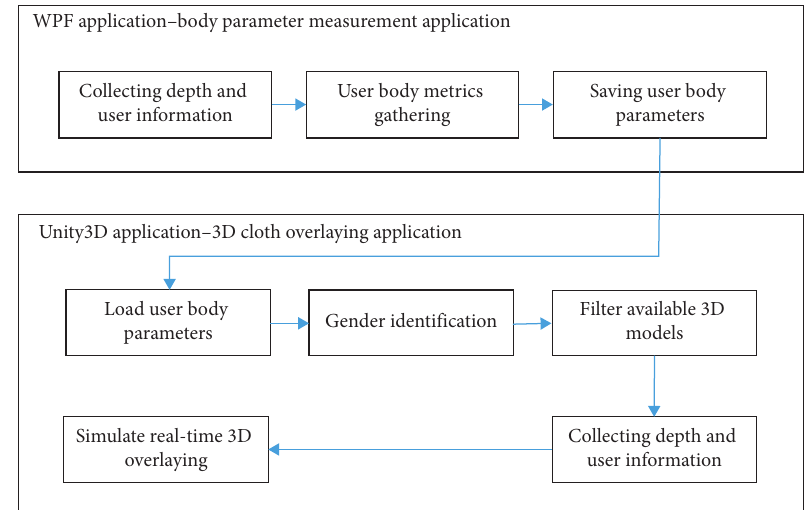
Figure 1: Augmented reality-based virtual fitting room overview.